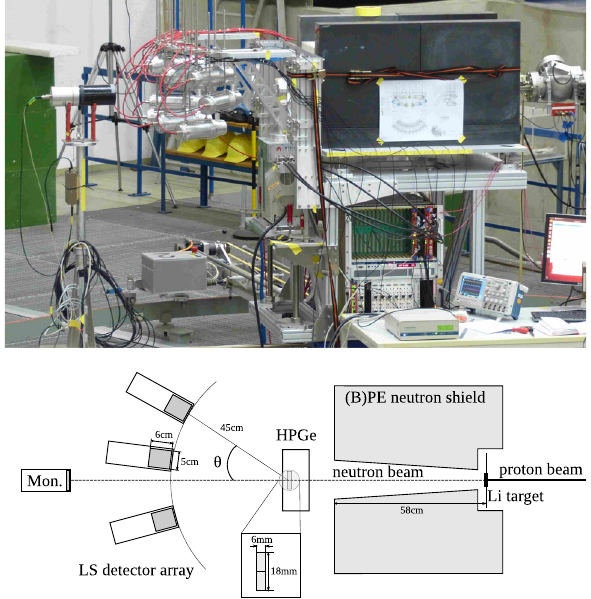
Fig. 1 Photo and scheme (not at scale) of the experiment installed at the PTB facility. The proton beam is coming from the right and hits the Li target, producing a neutron beam in the forward direction. Neutrons scatter off germanium nuclei in the HPGe target detector and are detected in coincidence with the LS detectors placed behind in a half-circle. Monitoring detectors (Mon.) placed at 0 degrees allow to measure the neutron energy distribution of the